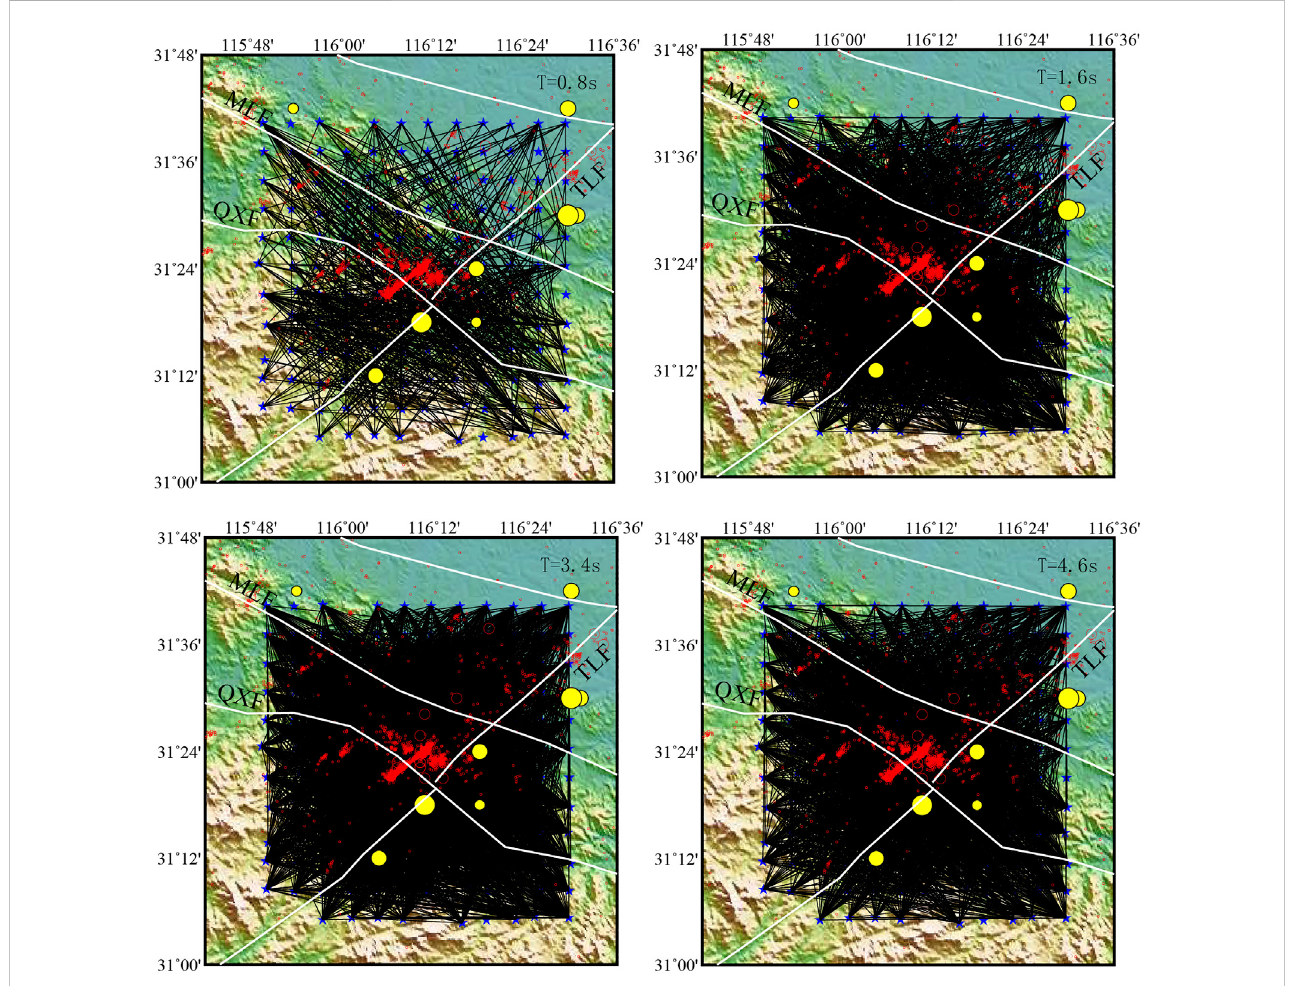
FIGURE 7 Distributionoftheray-pathcoveredinHuoshanandadjacentarea(T=1,2,3,4,5,7 s).Reddotsandcirclesrepresenttherelocatedearthquakeshavebeen occurred during 2010 – 2022 and yellow circles are the same shown in Figure